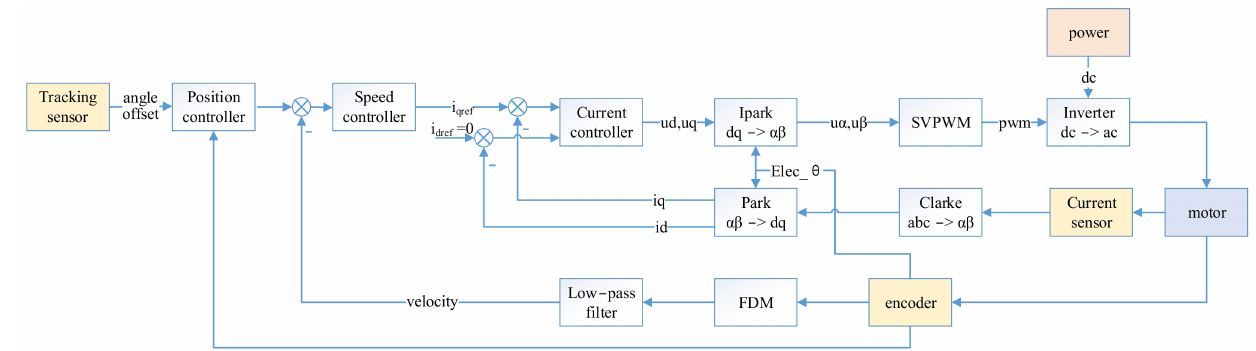
Figure 2. Single-axis control principle of the spectrometer.